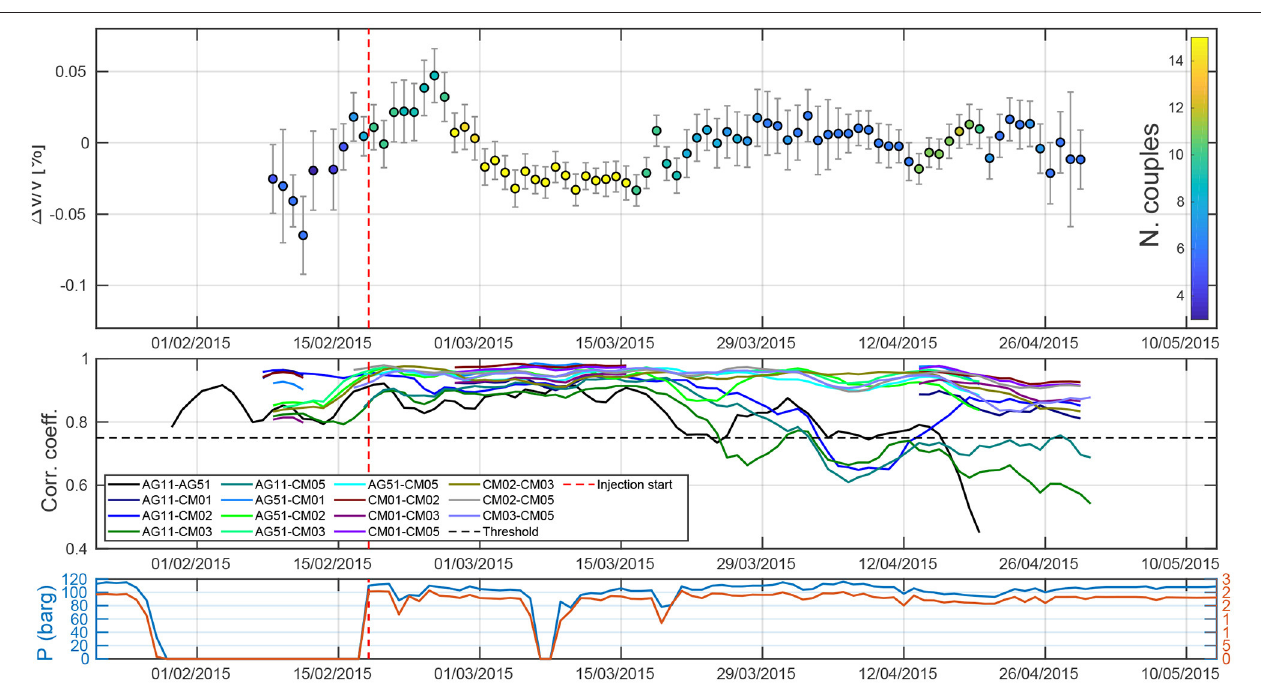
FIGURE 7 | (Top) Percentual crustal velocities variations as a function of time in the frequency band 0.1–1.0 Hz. Colors represent the number of station couples available at each time. (Middle) Correlation coefficient between currents and reference for each couple as a function of time. We exclude from the computation the data with a correlation coefficient lower than 0.75 (black dotted line). (Bottom) Injection daily pressure (red) and rate (blue) from De Gori et al. (2015).